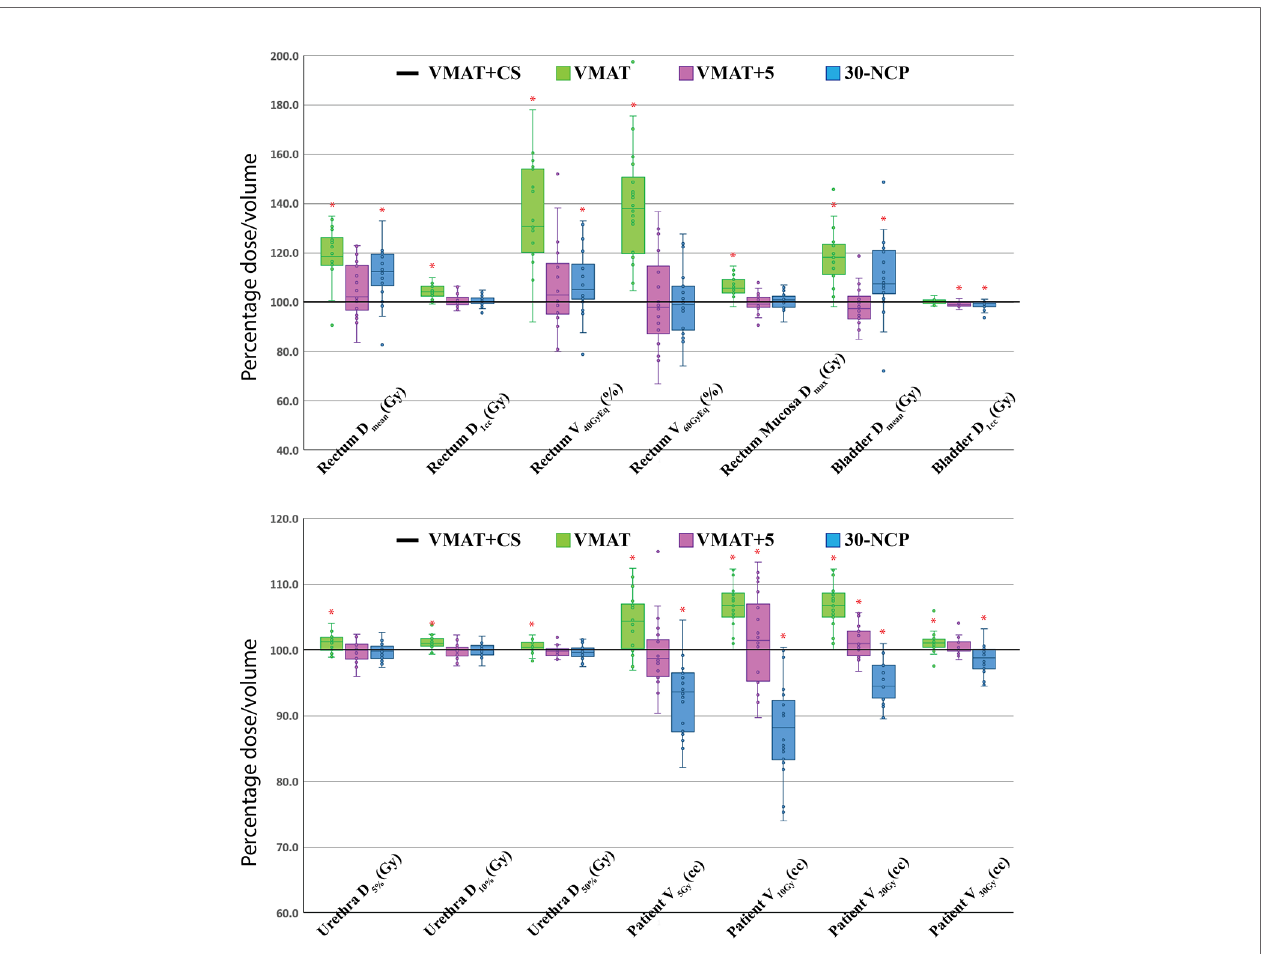
FIGURE 5 | Healthy tissue dose parameters for VMAT, VMAT+5, and 30-NCP plans relative to VMAT+CS (VMAT+CS always 100%) for all study patients. All plans were normalized to deliver the clinically required PTV coverage (V 38Gy =95%). The central line of each box represents the median value, and its upper and lower edge the 25th and 75th percentiles, respectively. The whiskers extend to the minimum and maximum values, or to 1.5 times the inter-quartile range from the top/bottom of the box. Hollow points are the discrete data points of the 20 study patients ( ‘ ° ’ ). Positive values indicate lower doses for VMAT+CS. *: difference with VMAT+CS is statistically signi fi